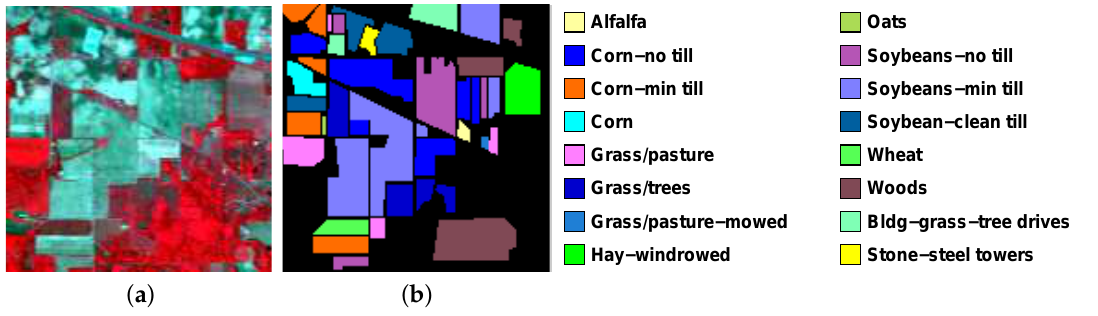
Figure 2. Airborne Visible/Infrared Imaging Spectrometer (AVIRIS) Indian Pines data set. ( a ) RGB composite image of three bands. ( b ) Ground-truth map.